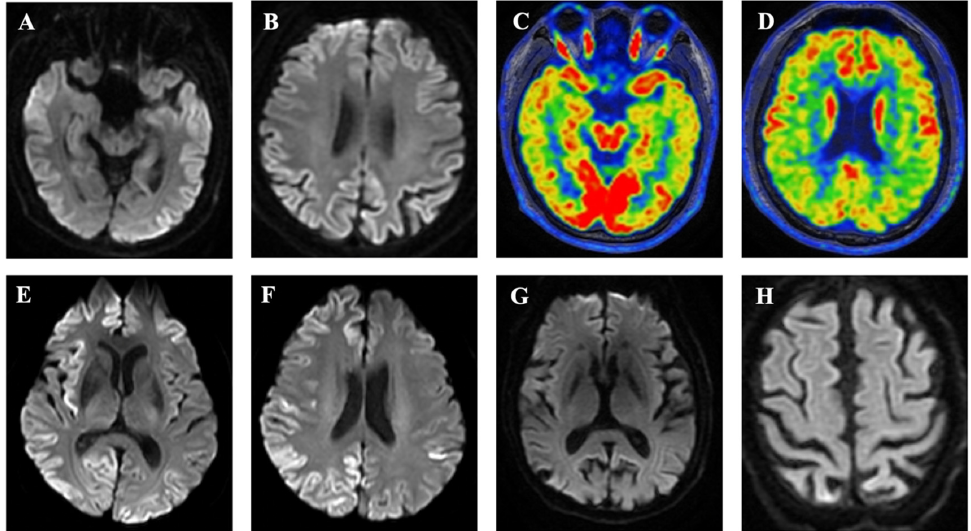
Figure 2. ( A , B ) MRI DWI data obtained on day 7 after the onset of symptoms in case IV-1 indicating bilateral symmetrical hyperintensity in the fronto-temporoparietal-occipital cortex and subcortex. ( C , D ) The 18 F-FDG PET data also showed significant hypometabolism in the aforementioned ar- eas. ( E , F ) MRI DWI data obtained on day 14 after the onset of symptoms in case III-4 indicating bilateral frontotemporal parietal occipital hyperintensity, with the right side being more prominent. ( G , H ) Brain MRI showed brain atrophy without hyperintensity in case